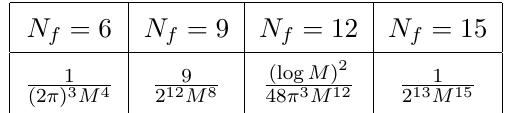
Table 4 . The leading part of ~ Z N f